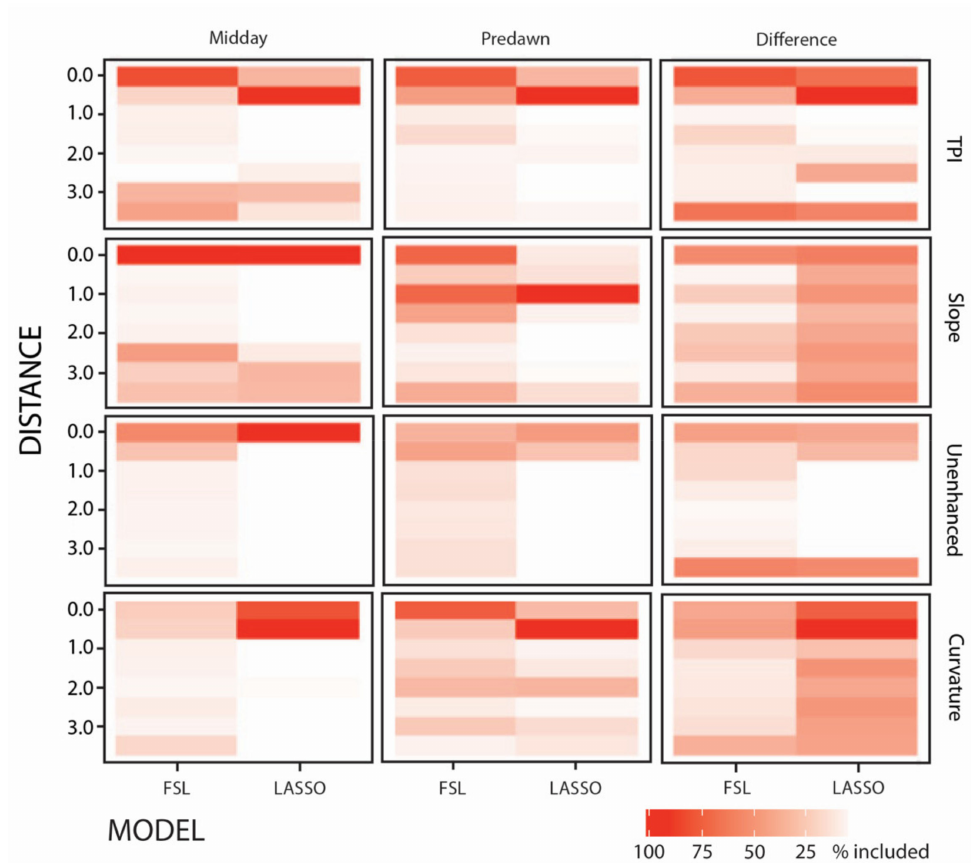
Figure 6. Covariates selected based upon 100 model iterations for both forward stepwise logistic (FSL) and Least Absolute Shrinkage and Selection Operator (LASSO) regression analyses. Dark red indicates high percentage (100%), while light pink is lowest percentage of model iterations identifying combinations of distance (in meters from cave entrance) and terrain analysis (Curvature, TPI, and Slope) and Unenhanced (i.e., unenhanced thermal) data layers for predawn, midday and difference imagery.